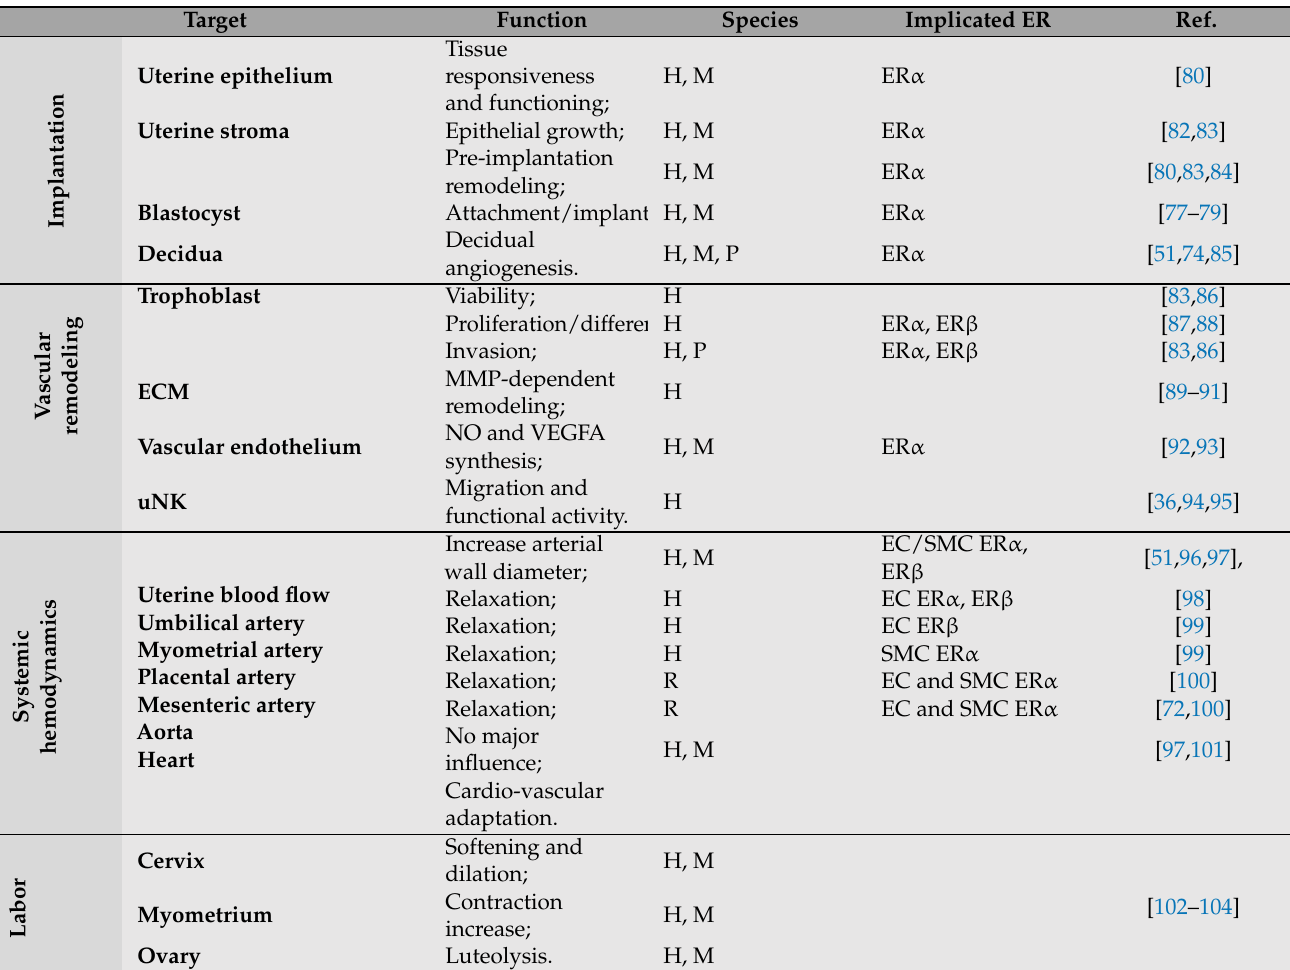
Table 2. Main biological functions mediated by estrogens during pregnancy . H: human; M: mouse; P: primate; R: rat; EC: endothelial cell; SMC: smooth muscle cell; OXTR: oxytocin receptor; CX43: Connexin43; PG(R): prostaglandin (receptor).